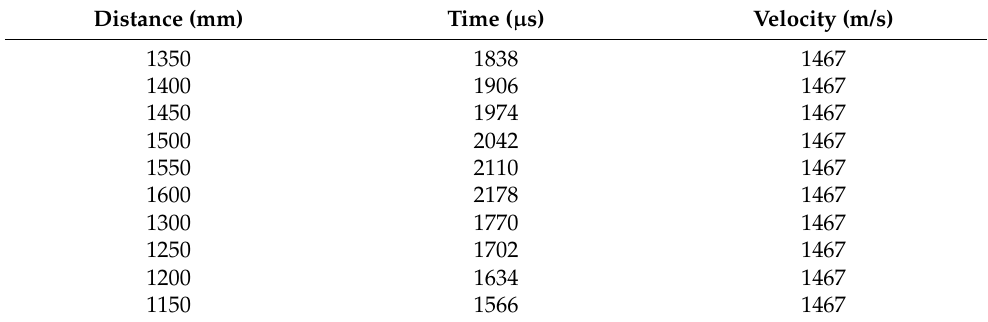
Table 3. Time and acoustic propagation velocity of the echo received by probe No. 1 at different distances.